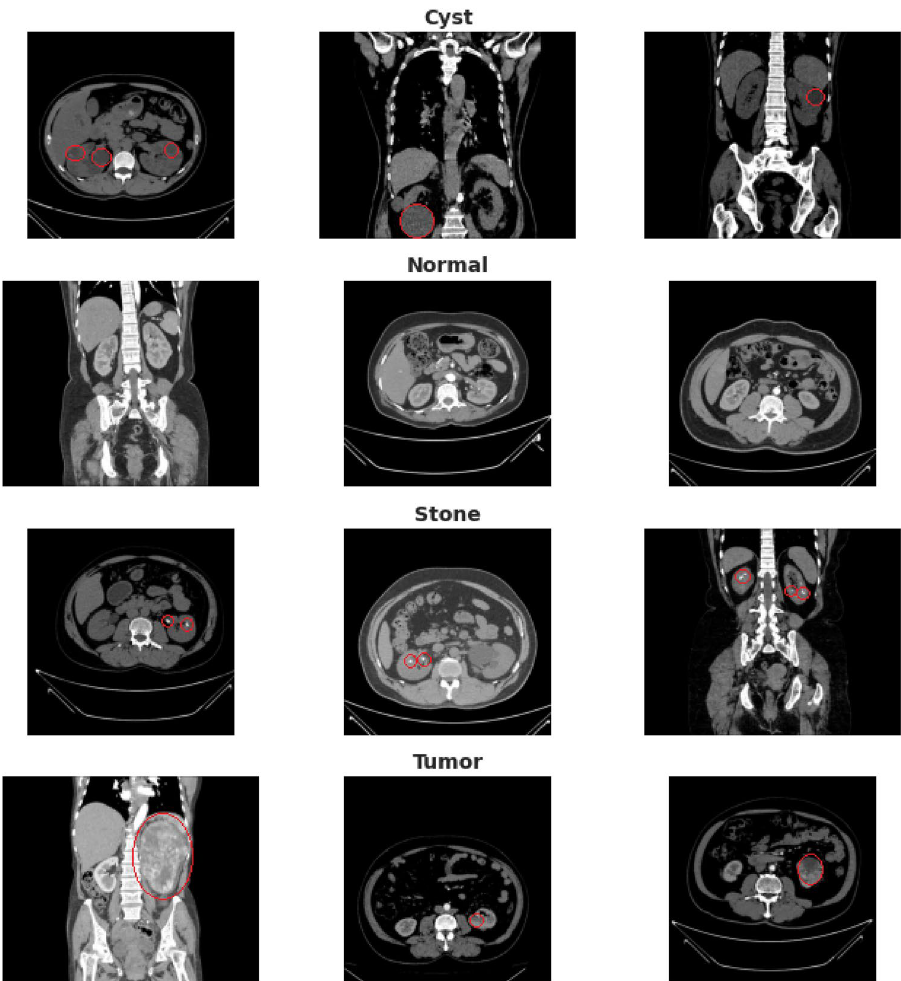
Figure 2. sample image data of kidney cysts, normal, stone and tumor